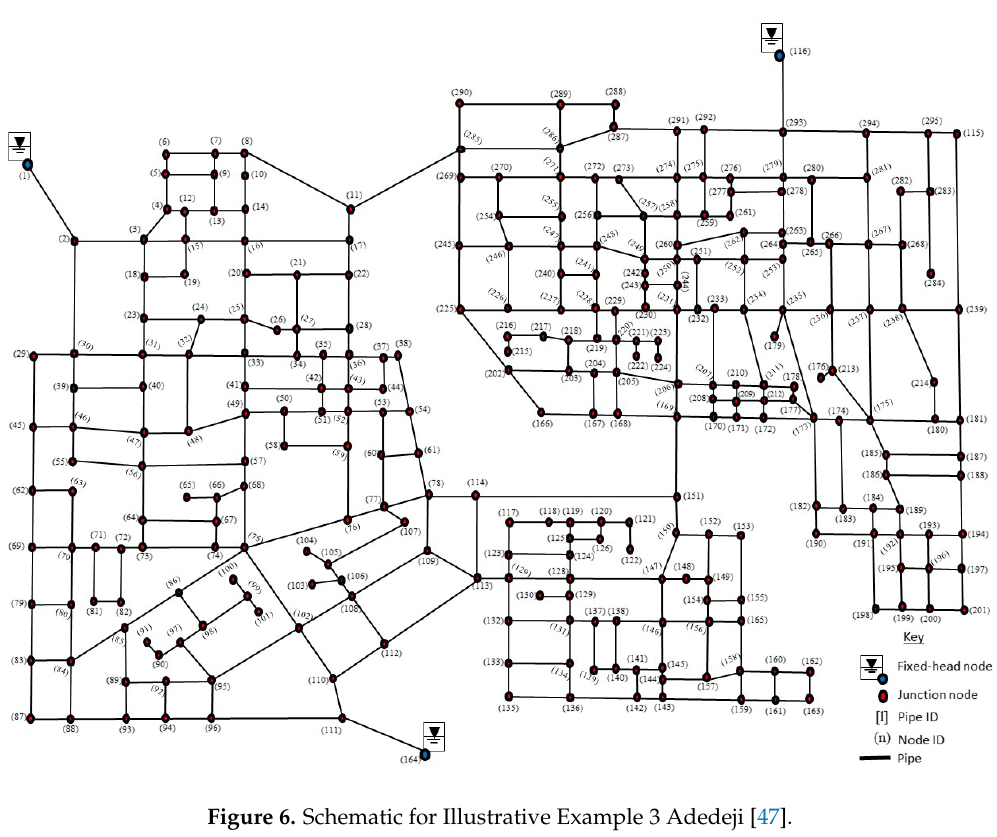
Figure 6. Schematic for Illustrative Example 3 Adedeji [47].